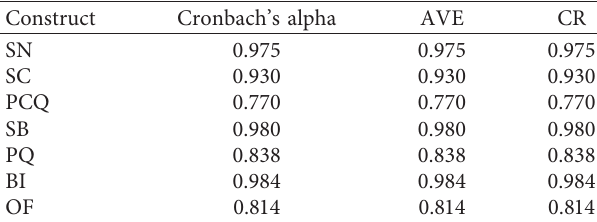
Table 3: Demographic statistics. Table 4: Reliability and validity test